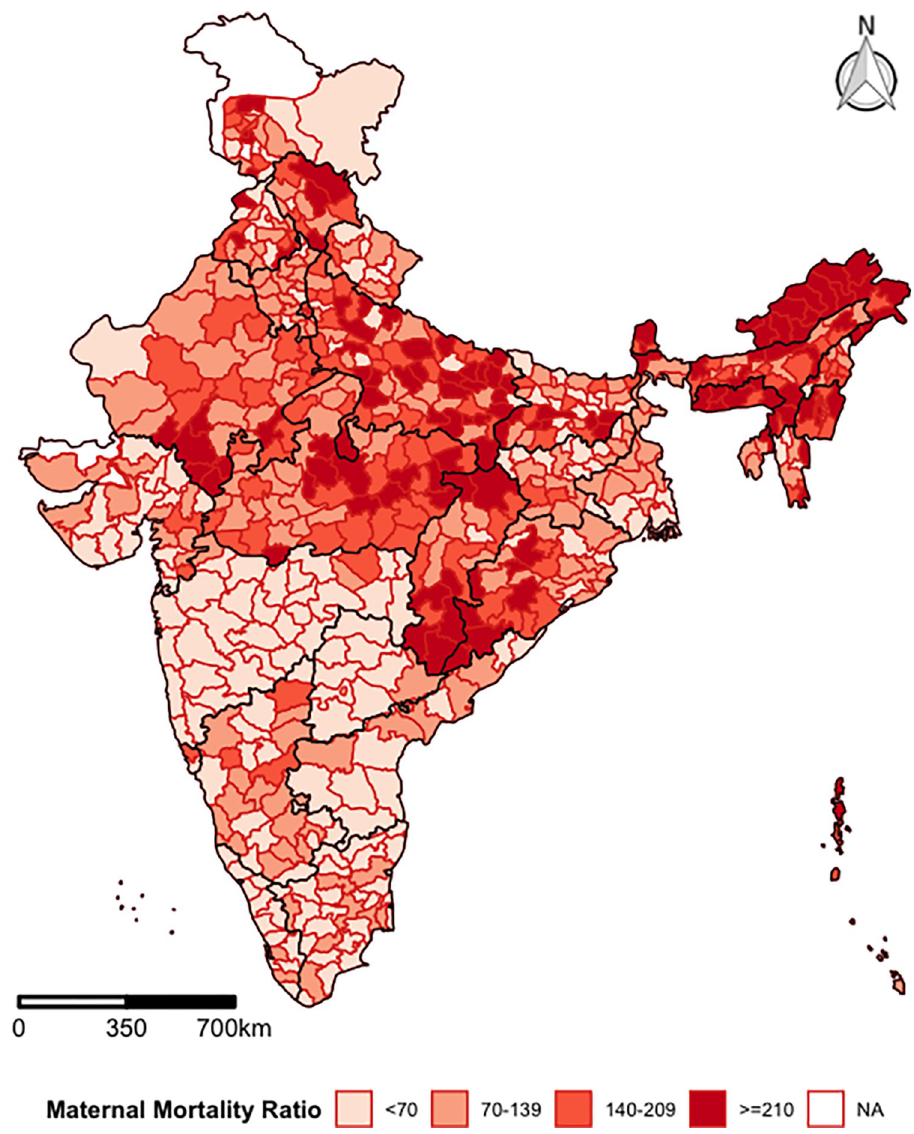
Fig 2. Geographical pattern of maternal mortality ratio by 640 districts in India, HMIS. (https://github.com/ datameet/maps/). (Authors generated the estimates employing the HMIS data).